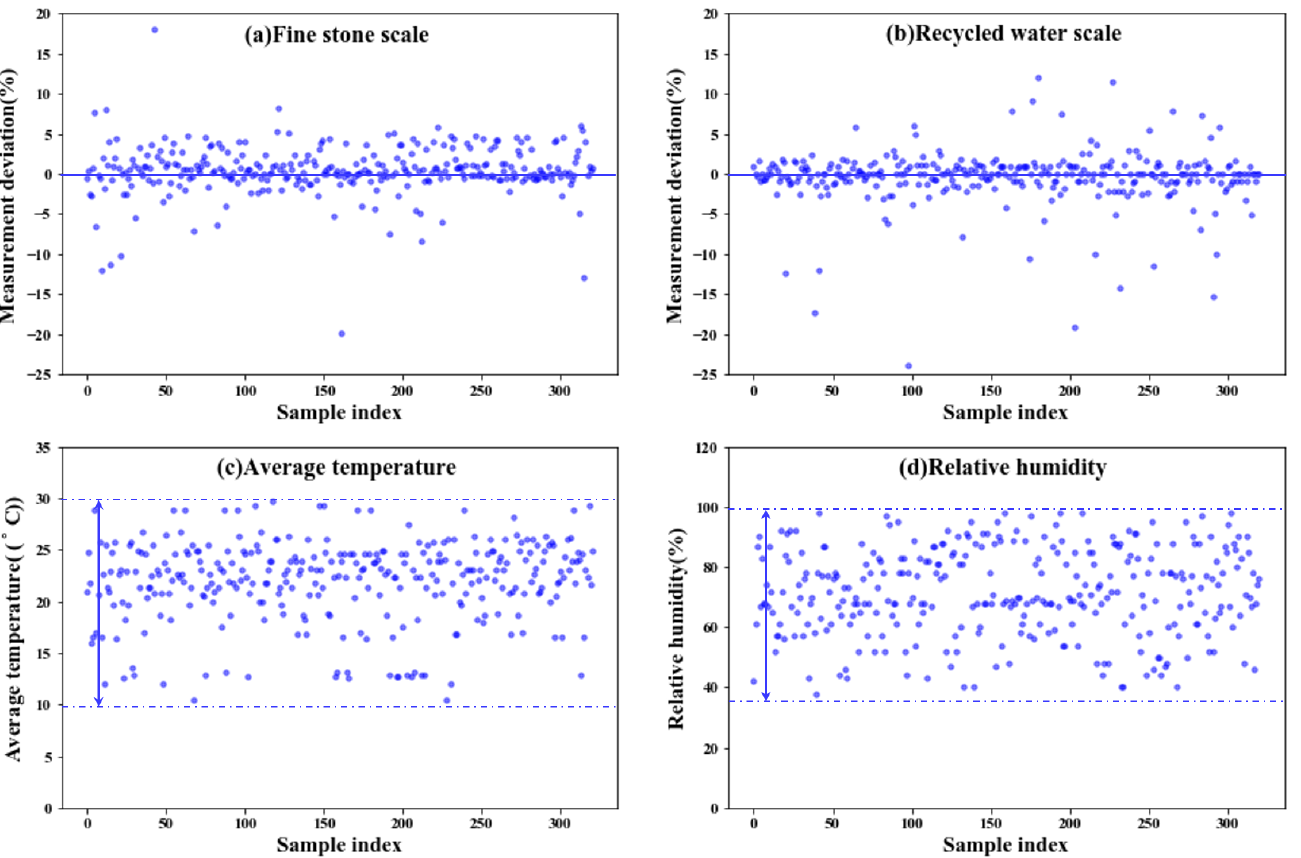
Figure 7. Scatter plot of some influencing factors of concrete, ( a ) fine stone scale; ( b ) recycled water scale; ( c ) average temperature; ( d ) relative